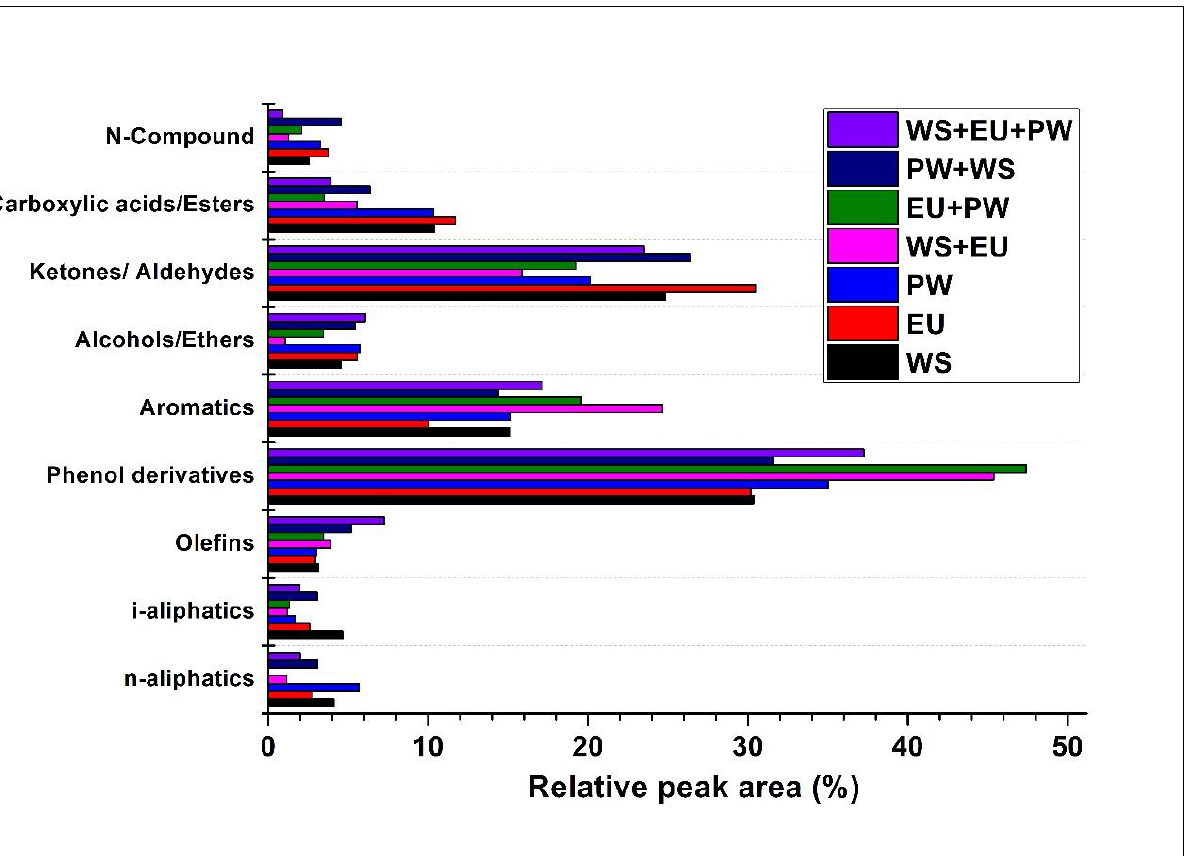
Figure 4. Compound composition of bio-crude.